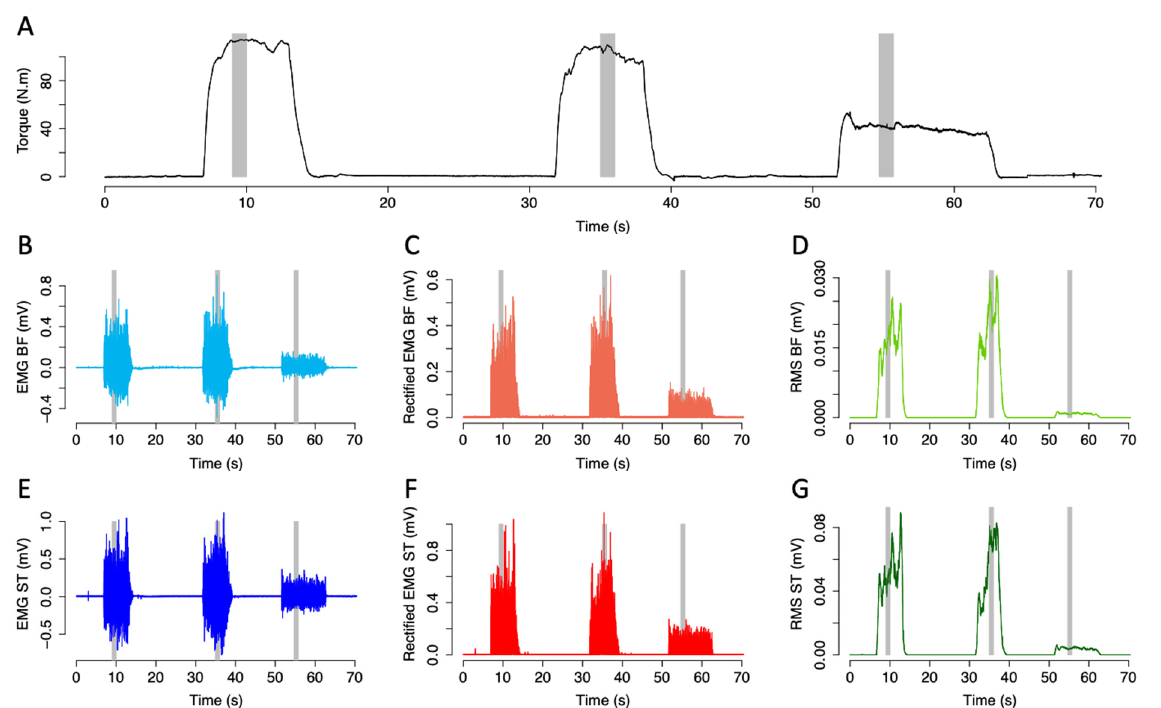
Figure 2. Torque and electromyography (EMG) traces for biceps femoris ( B , F ) and semitendinosus (ST) during maximal and sub-maximal contractions for a representative volunteer. Torque ( A ), raw EMG ( B , E ), filtered and rectified (EMG)( C , F ) and root mean square (RMS; ( D , G )). During maximal contractions and sub-maximal contractions, 1 s windows were considered for analyses (gray area).